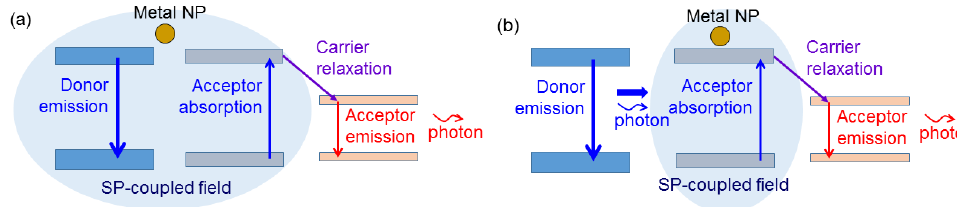
Figure 4. ( a ) Schematic illustration of an SP-coupled down-conversion process when the SP resonance spectrum covers only the emission wavelength of the donor, and the donor, acceptor, and metal NP are close to each other. ( b ) Schematic illustration of an SP-coupled down-conversion process when the SP resonance spectrum covers only the emission wavelength of the donor, and the donor and acceptor are far apart.